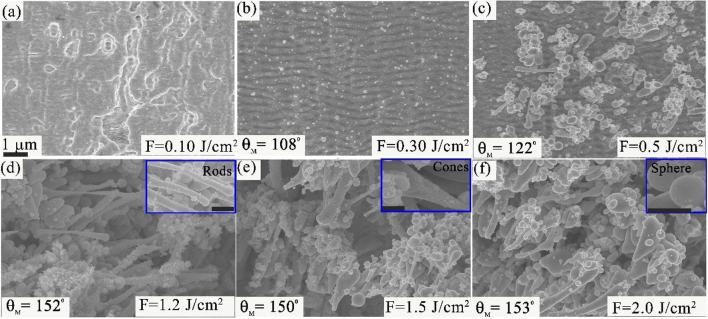
SEM images showing the evolution of laser-induced surface structures with varying the laser fluence. (a) SEM images of random roughness at F = 0.1 J/cm2, (b) fs-LIPSSs at F = 0.30 J/cm2, (c) fs-LIPSSs covered with nano/microstructures at F = 0.5 J/cm2, a combination of 1D rods, conical and spherical structures at (d) F = 1.2 J/cm2, F = 1.5 J/cm2, and F = 2.0 J/cm2. The measured values of θM for different surface structures are shown. The insets of Fig. 4(d-f) are the rods, cones and spherical structures, respectively. The scale-bar in the insets is 500 nm. The scale-bar of 1 µm shown in Fig. 4(a) is same for Fig. 4(a-f).